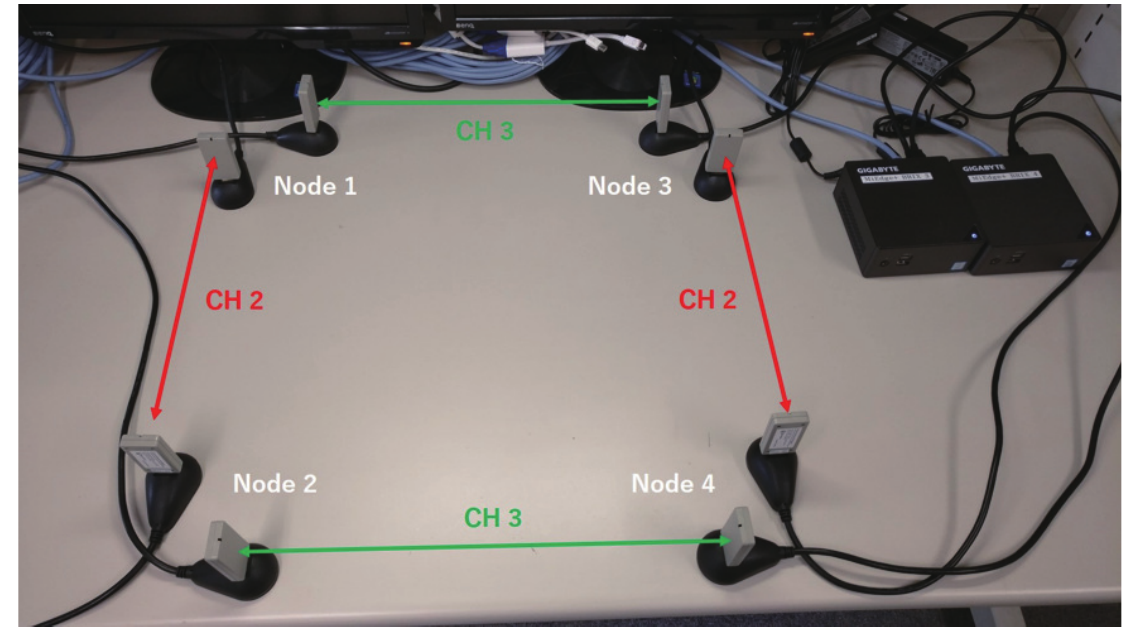
Figure 10. Photo of mmWave meshed network testbed.